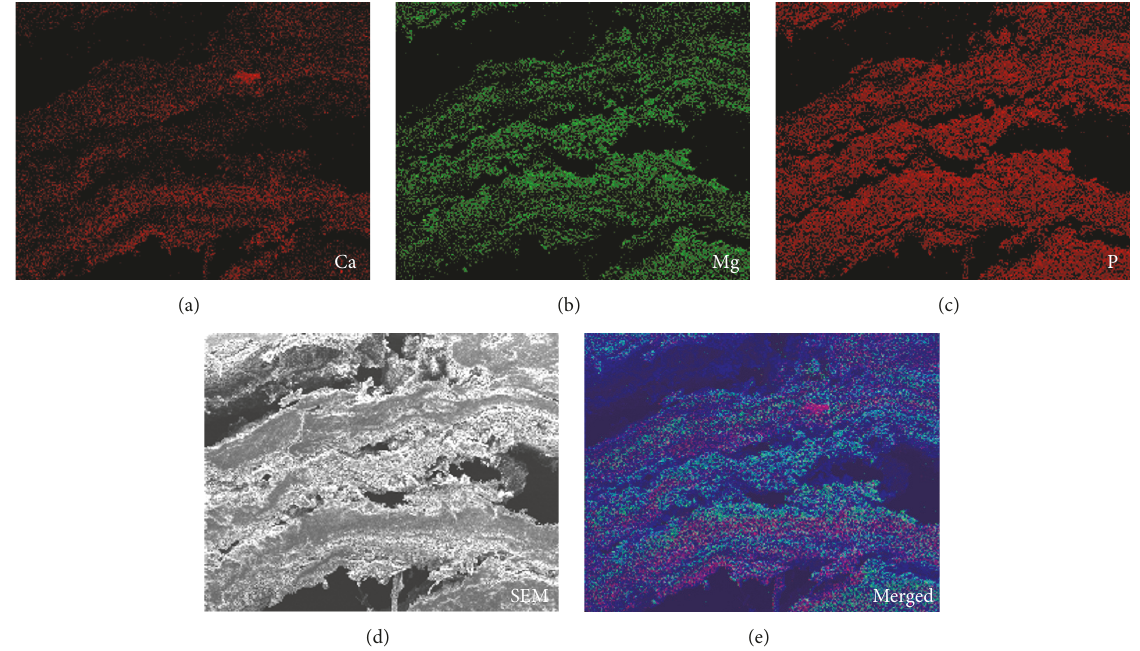
Figure 5: Elemental mapping images. The enterolith piece immersed in water contained calcium (a), magnesium (b), and phosphate (c). A photograph merged with a scanning electron microscopy image (d) and mapping images of calcium and magnesium showed that the enterolith piece was composed of two kinds of layers (e).